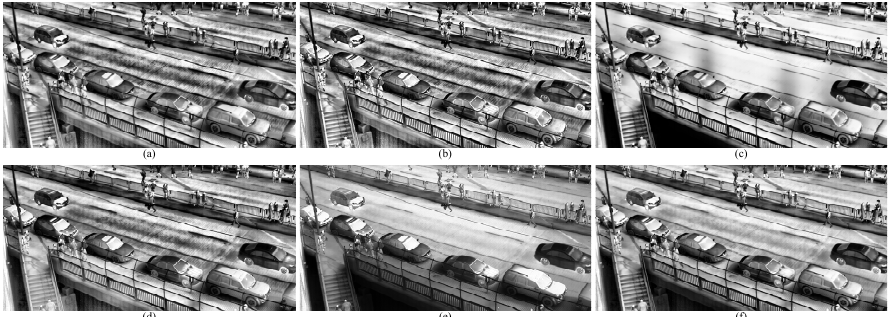
Figure 14. Enhancement results for Road. ( a ) CLAHE, ( b ) BCCE, ( c ) ABMHE, ( d ) LGGSF, ( e ) GLHS, ( f ) Proposed.